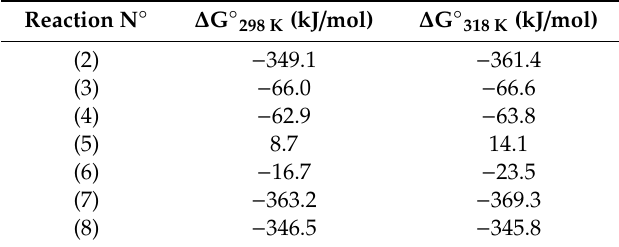
Table 1. Standard Gibbs free energies for the CuFeS 2 -H 2 SO 4 -NaNO 3 -H 2 O system at 298 K and 318 K (reactions taken Soki´c et al. [16] and values corrected using HSC